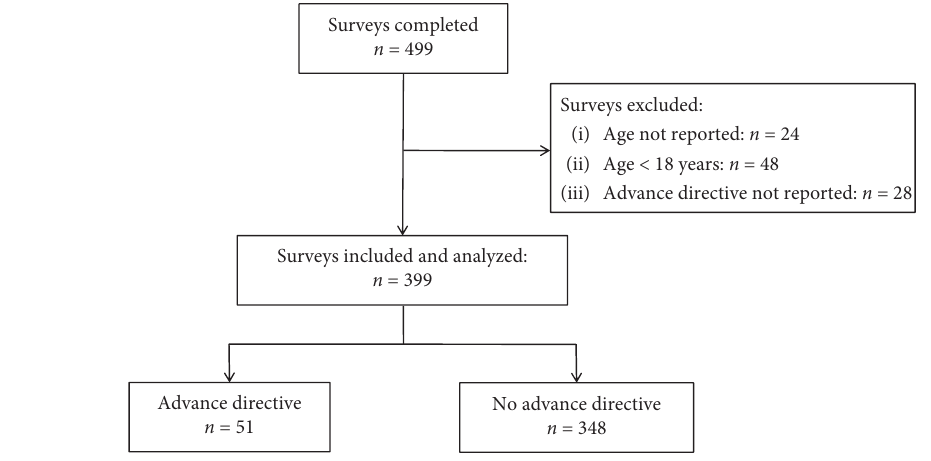
Figure 1: Consort diagram. Table 1: Patient characteristics.